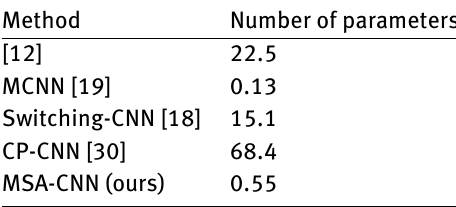
petitive MSE score, which indicates the robustness of predicted count. Considering practical applications of crowd counting algorithm, we perform a simple and practical study. As shown in Table 4, MCNN has the least parameters, and CP-CNN is 500 times more than MCNN. In contrast, our algorithm has a relatively small amount of parameters.